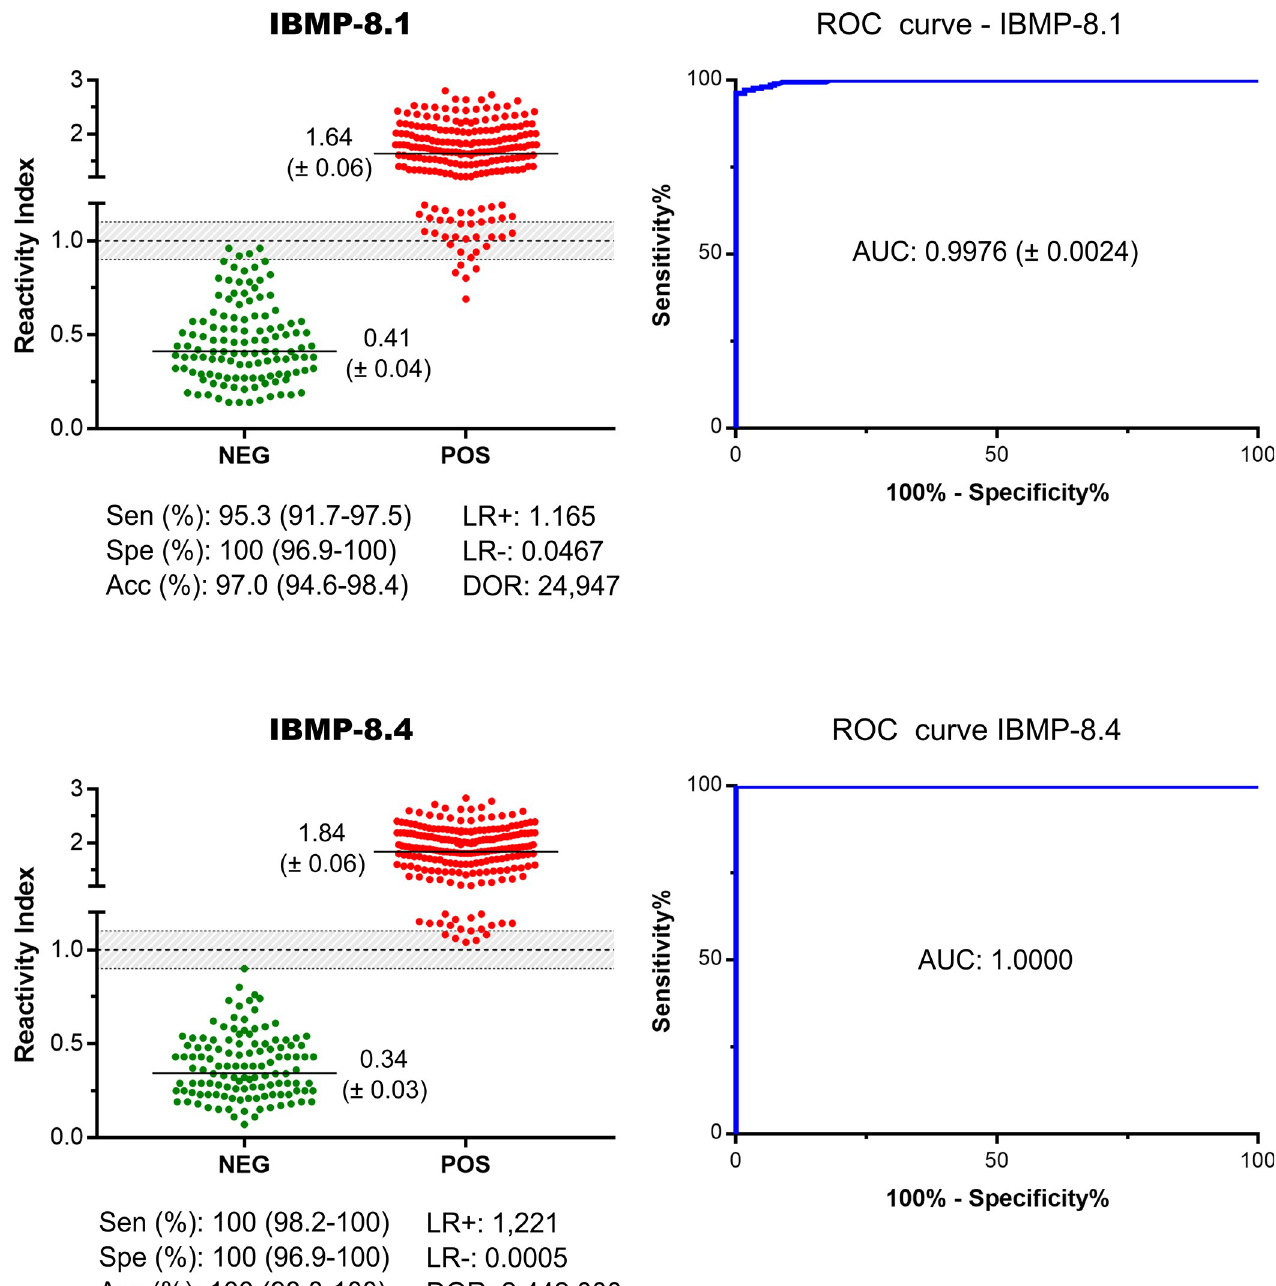
Fig 3. Reactivity index and performance parameters obtained with serum samples from T . cruzi -infected (POS) and non-infected (NEG) individuals. The cut-off value is reactivity index = 1.0 and the shadowed area represents the grey zone (RI = 1.0 ± 0.10). Horizontal lines and numbers for each group of results represent the geometric means ( ± 95% CI). AUC (Area Under Curve); Sen (Sensitivity); Spe (Specificity); Acc (Accuracy); LR (Likelihood Ratio); DOR (Diagnostic Odds